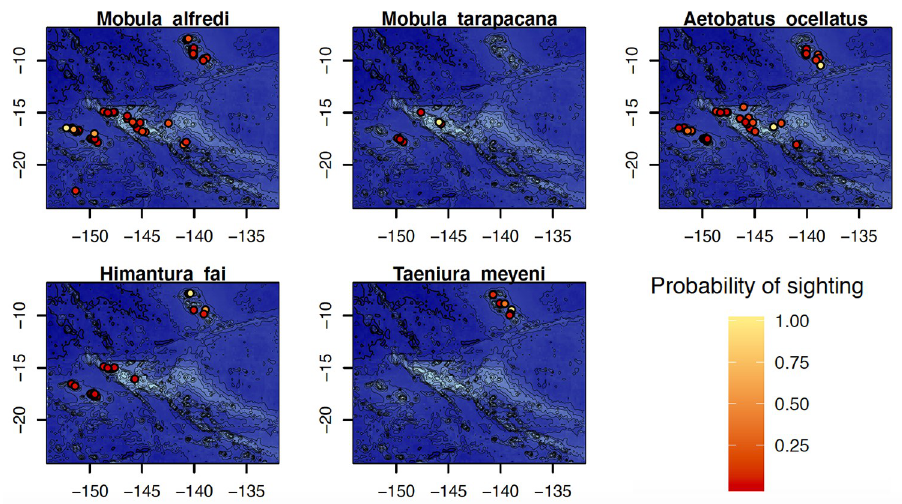
Fig 6. Distribution and probability of encounter of 5 ray species in French